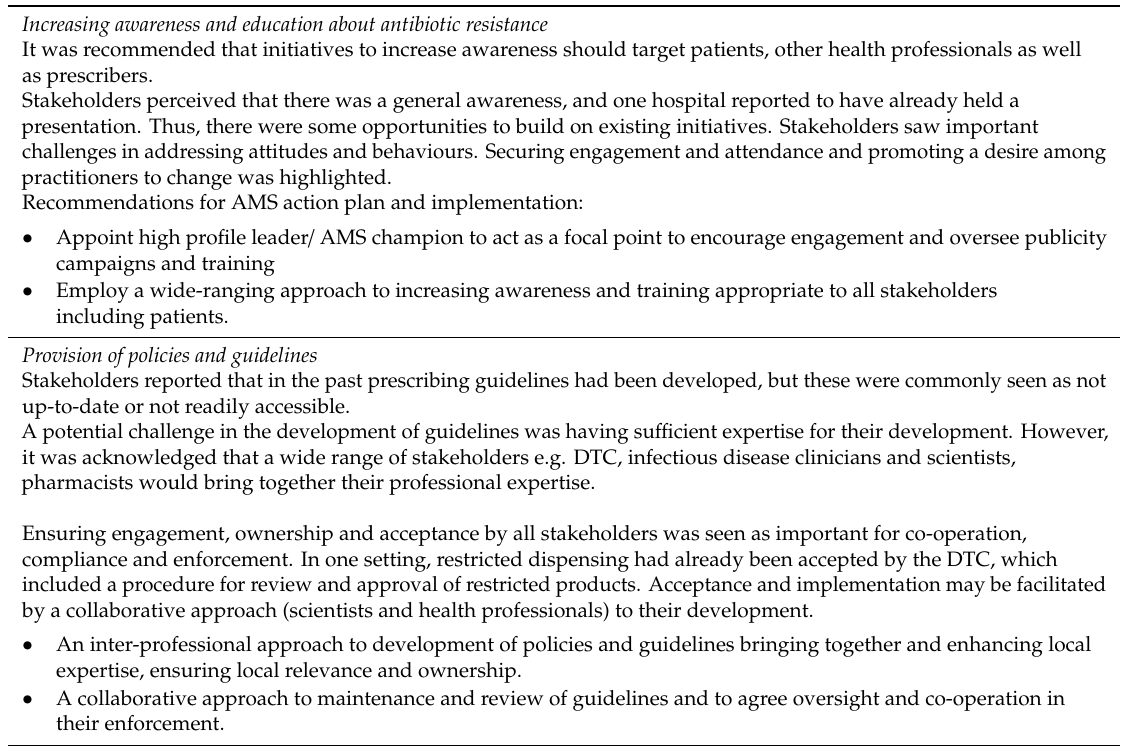
Table 4. Priorities, opportunities, and barriers leading to action